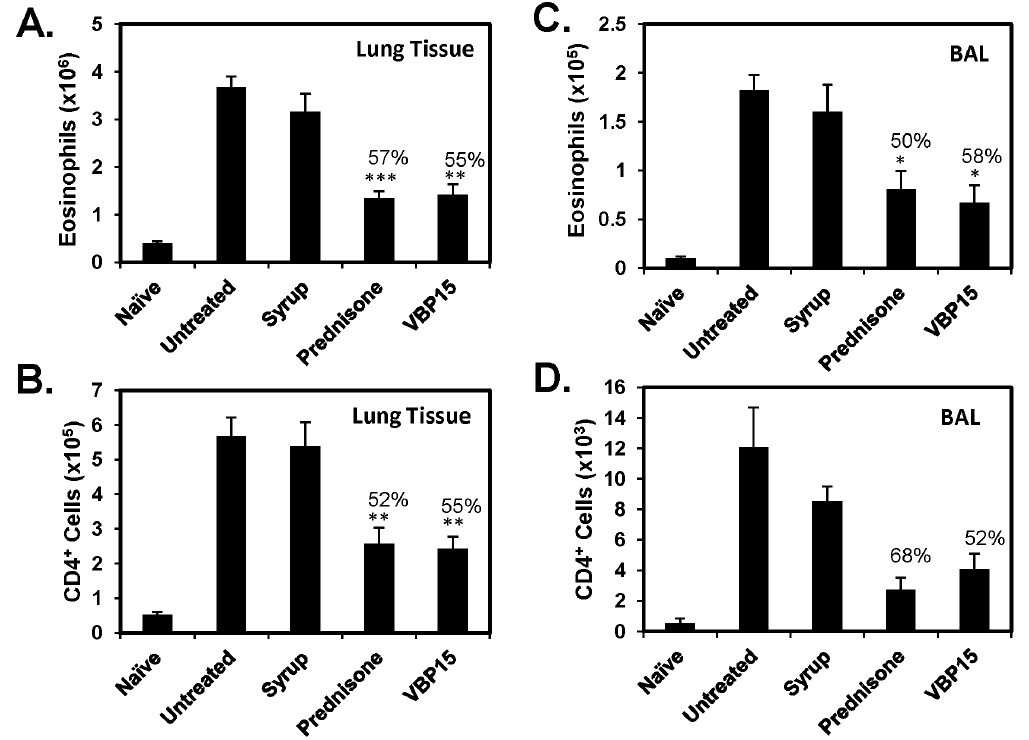
Figure 2. VBP15 reduces leukocyte infiltration in the OVA-induced model of acute allergic lung inflammation. OVA-challenged mice were either left untreated or treated with oral doses of prednisone, VBP15 (20 mg/kg), or cherry syrup alone daily for 6 days. A group of non- challenged mice (naı¨ve) was included in order to assess basal inflammatory parameters. Lung tissue and BAL cells underwent FACS analysis to determine the number of infiltrating eosinophils (A and C) and effector/memory CD4 + T cells (B and D). Bar graphs represent mean ( 6 SE) cell numbers. Percentages indicate percentage reduction compared to vehicle control. * p , 0.05; ** p , 0.01; *** p , .001 compared to syrup group with n=5 mice per group.